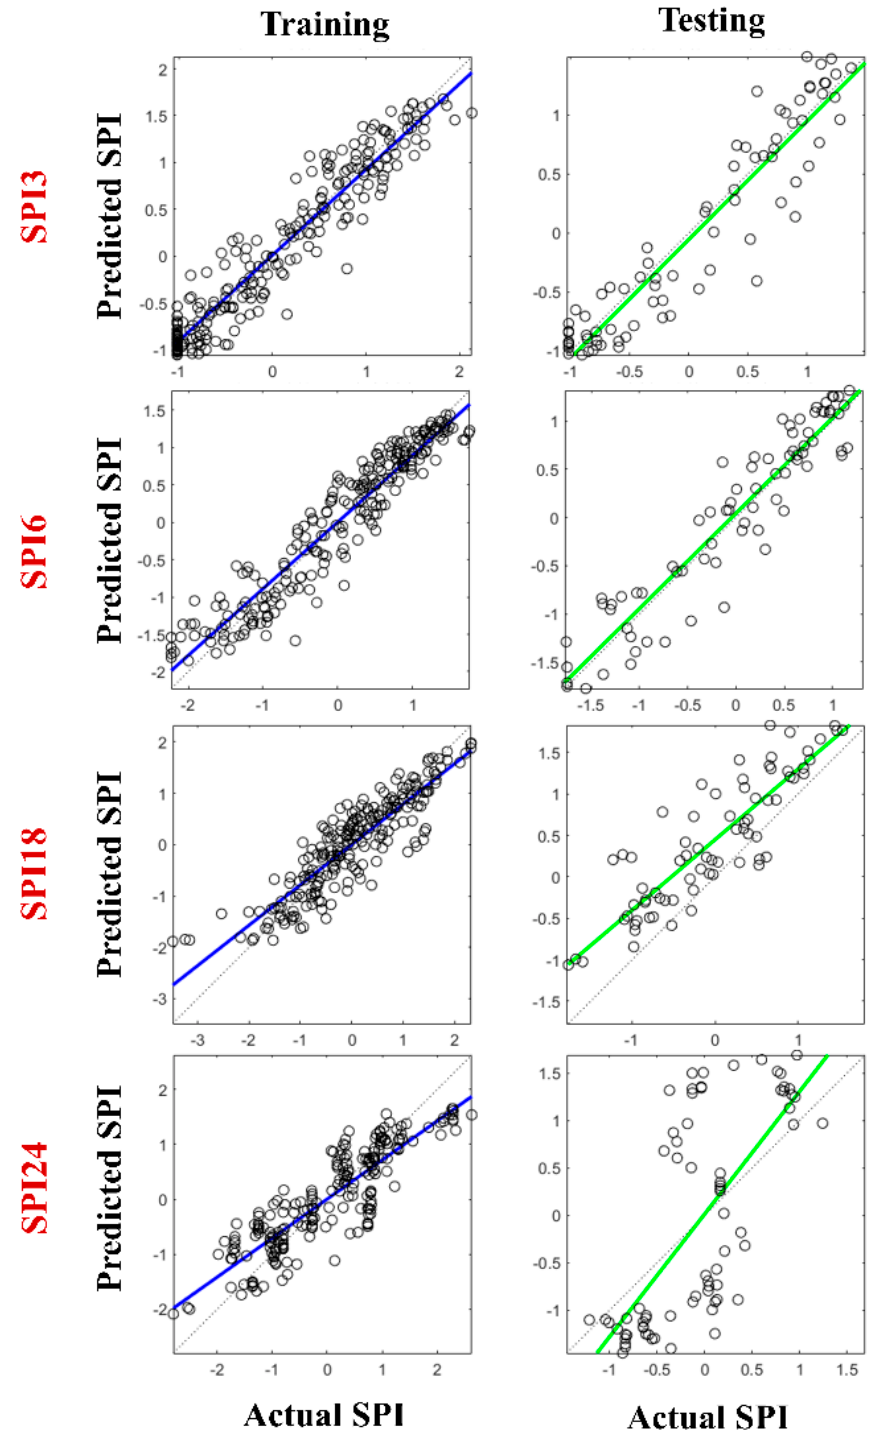
Figure 4. The actual SPI at different time scales vs. the predicted SPI via ANN-FA.